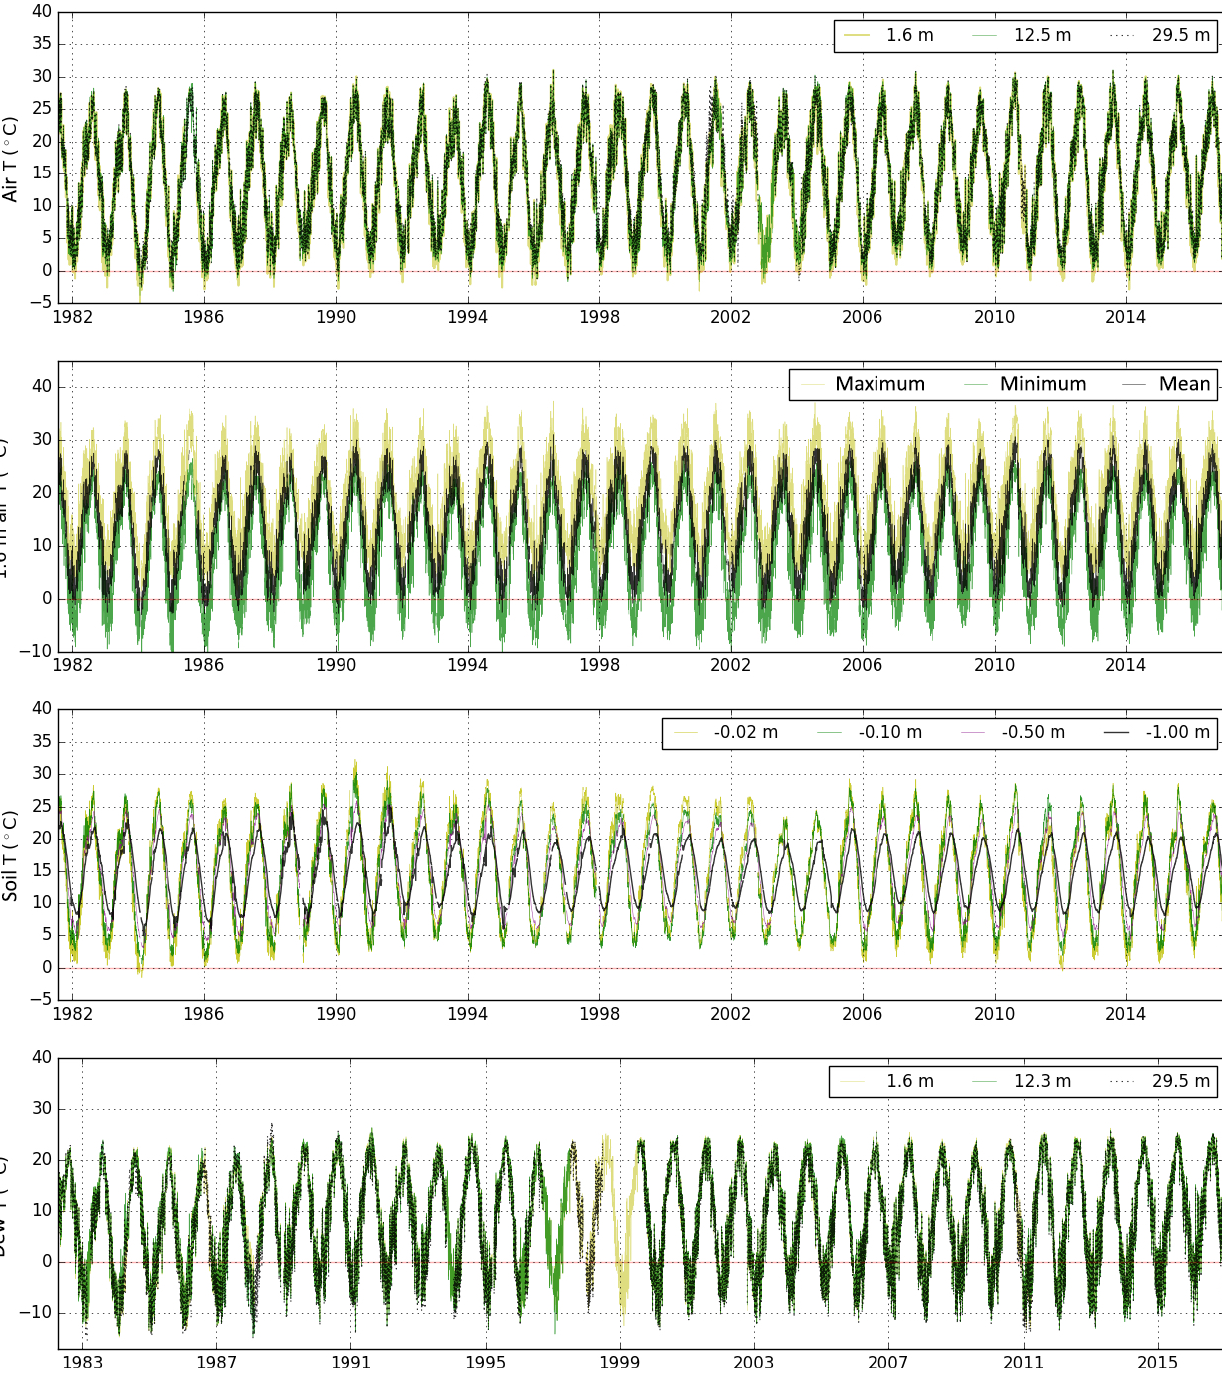
the balance of net radiation is governed by the balance of the shortwave and longwave radiation. An observed positive air-temperature trend is evident since 1981 (Fig. 5j), which is consistent with the global trend related to climate change and an increasing temperature. The average, maximum and